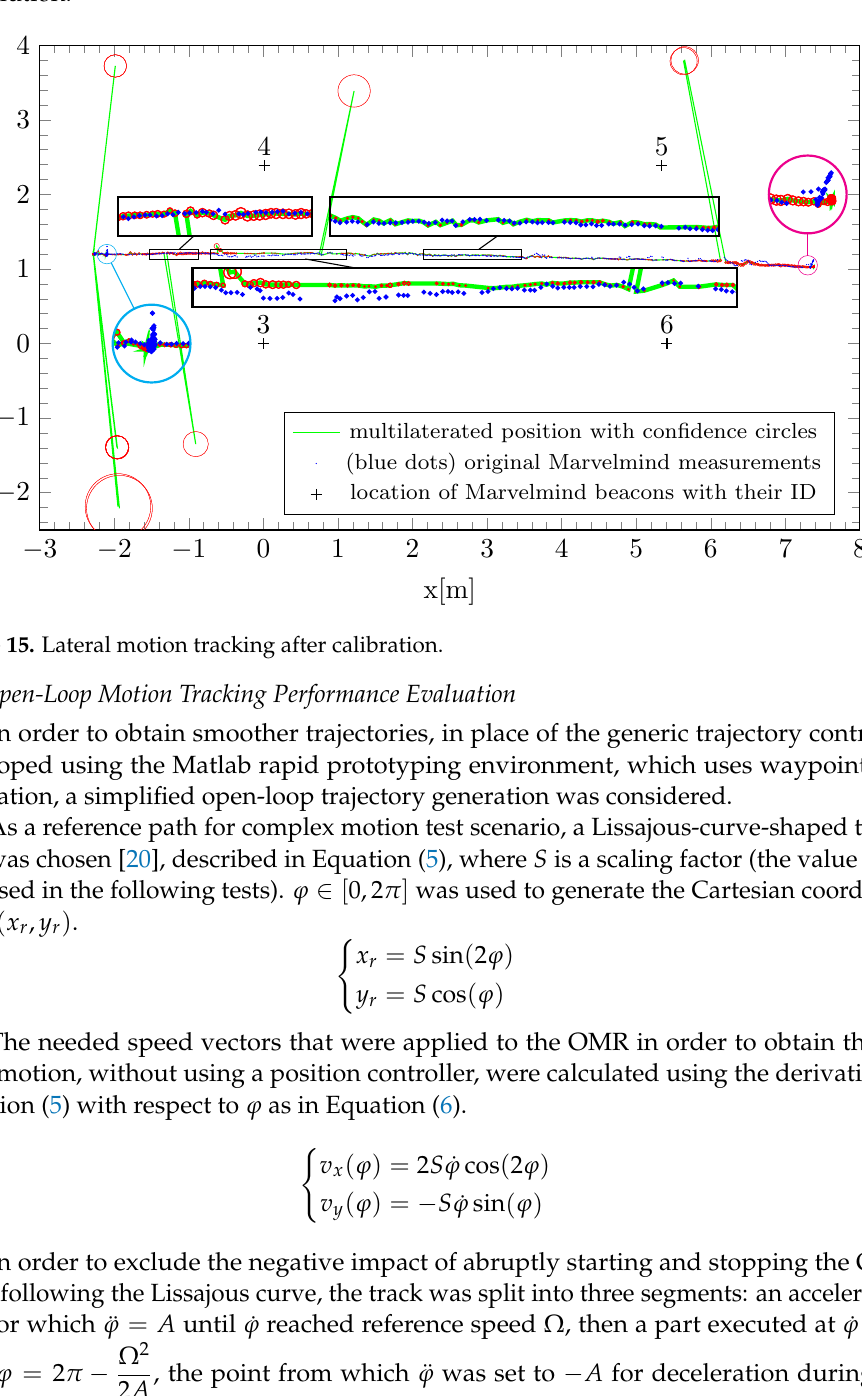
multilaterated position with confidence circles (blue dots) original Marvelmind measurements location of Marvelmind beacons with their ID